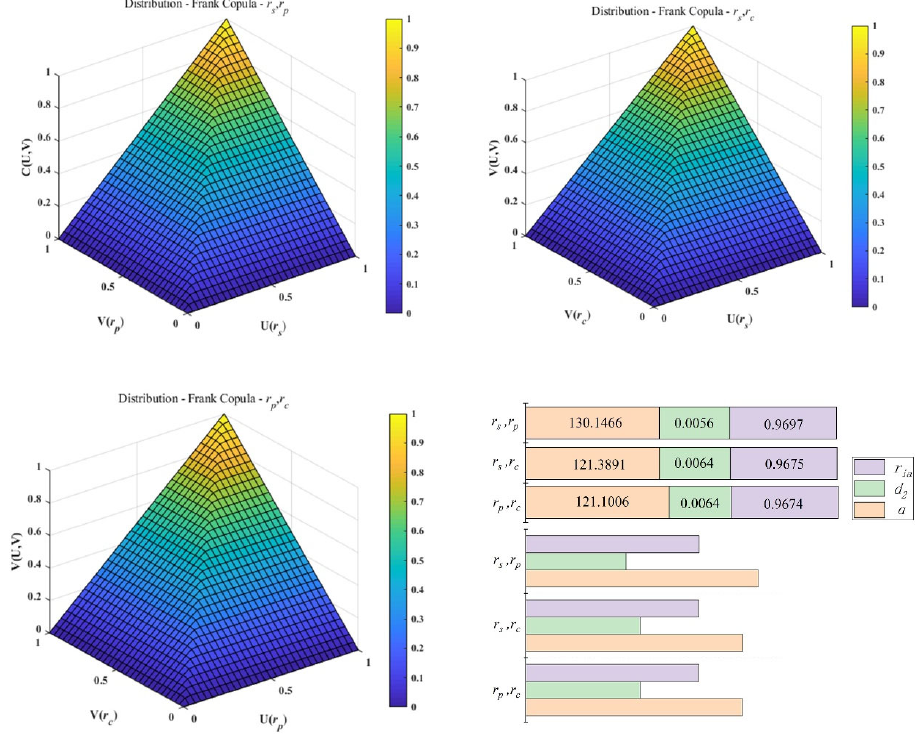
Figure 7. Distributions of the Frank Copula function.